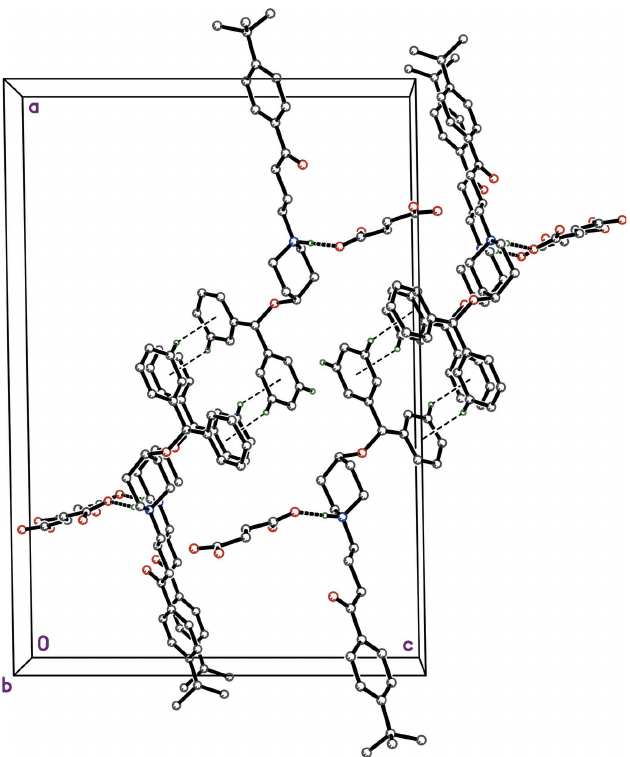
Figure 4 A partial packing plot of I viewed down the b -axis direction showing C— H (cid:2)(cid:2)(cid:2) (cid:2) contacts (thin dashed lines) between the diphenylmethoxy groups, thereby forming the interface, centered on a = 1/2, between layers parallel to the bc plane. In the interests of clarity, the minor component of disorder is